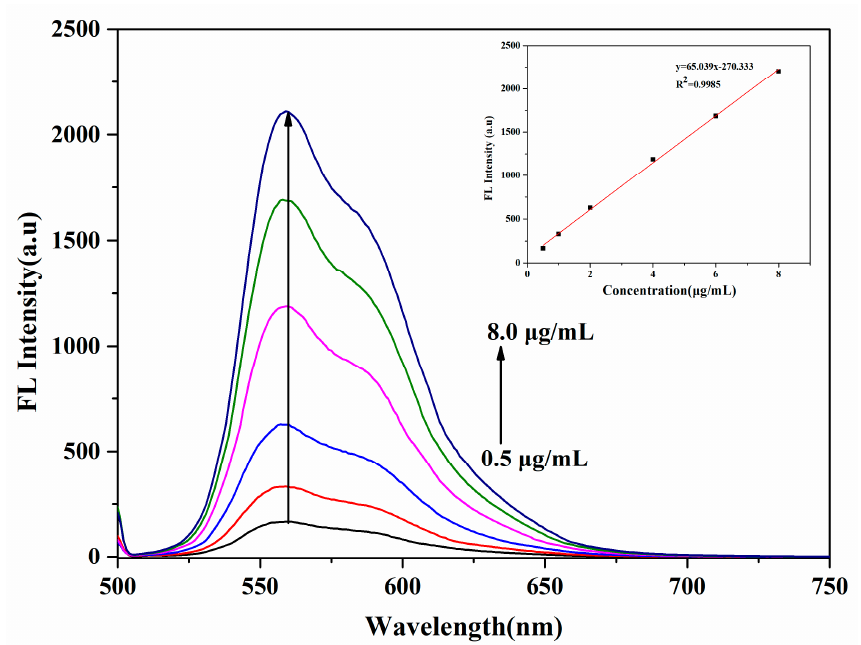
Figure 7. Fluorescence spectra of different concentrations of DOX and its standard curve.